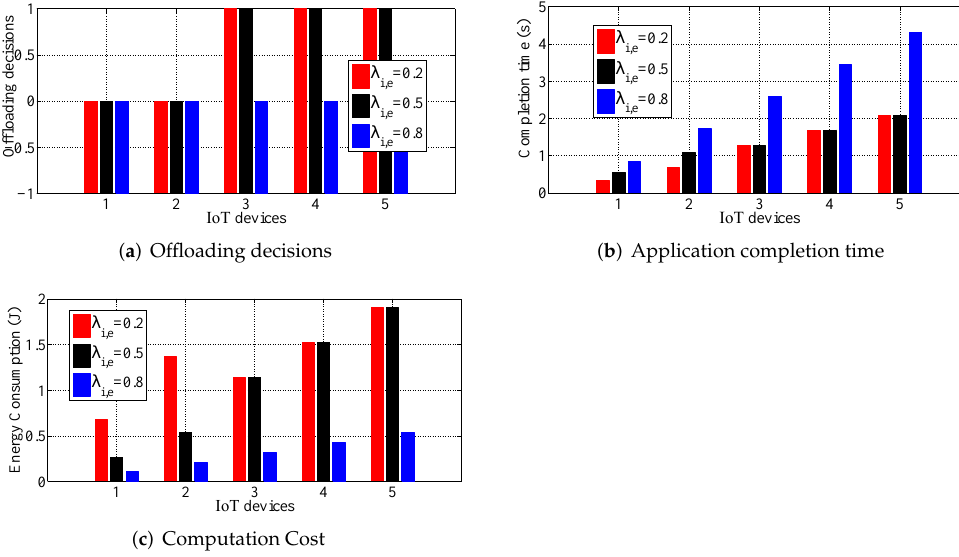
Figure 3. The effect of the weight coefficient